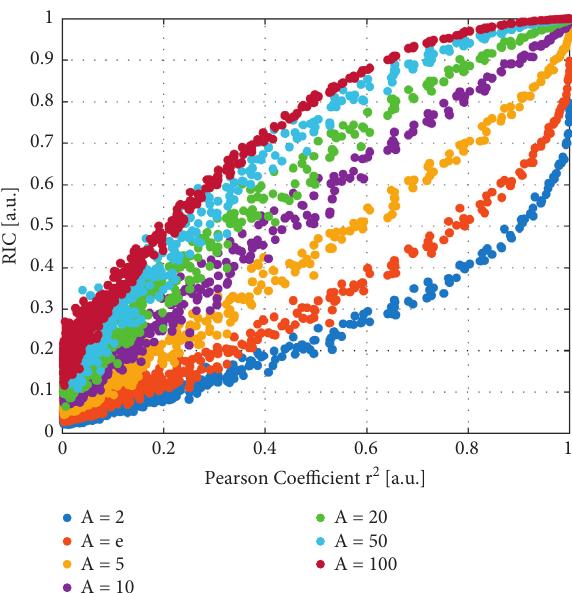
Figure 8: Trends of RIC versus the squared Pearson correlation coefficient for various values of A